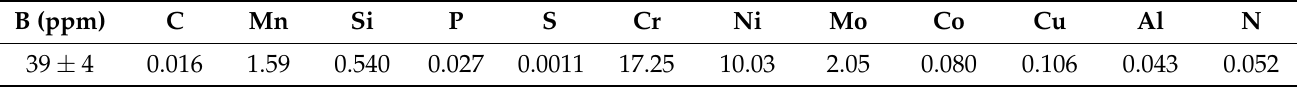
Table A3. Chemical composition of the 316L stainless steel specimen (in percentages except for boron). B